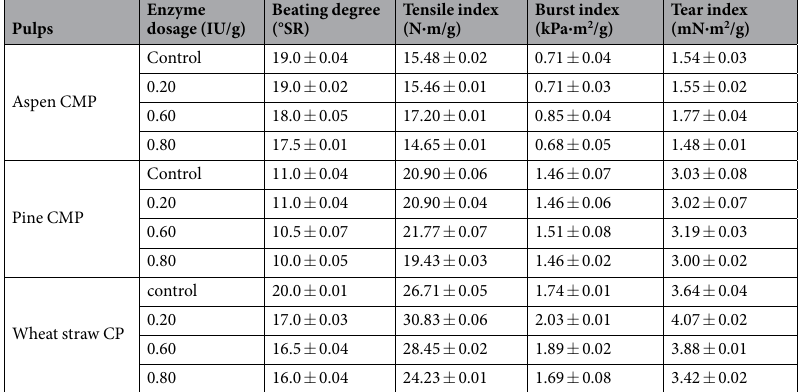
Table 1. Effect of enzyme dosages on physical properties of pulps. * Enzyme treatment conditions: pH 7.0, temperature 55 °C, 10% pulp consistency and treatment time 2